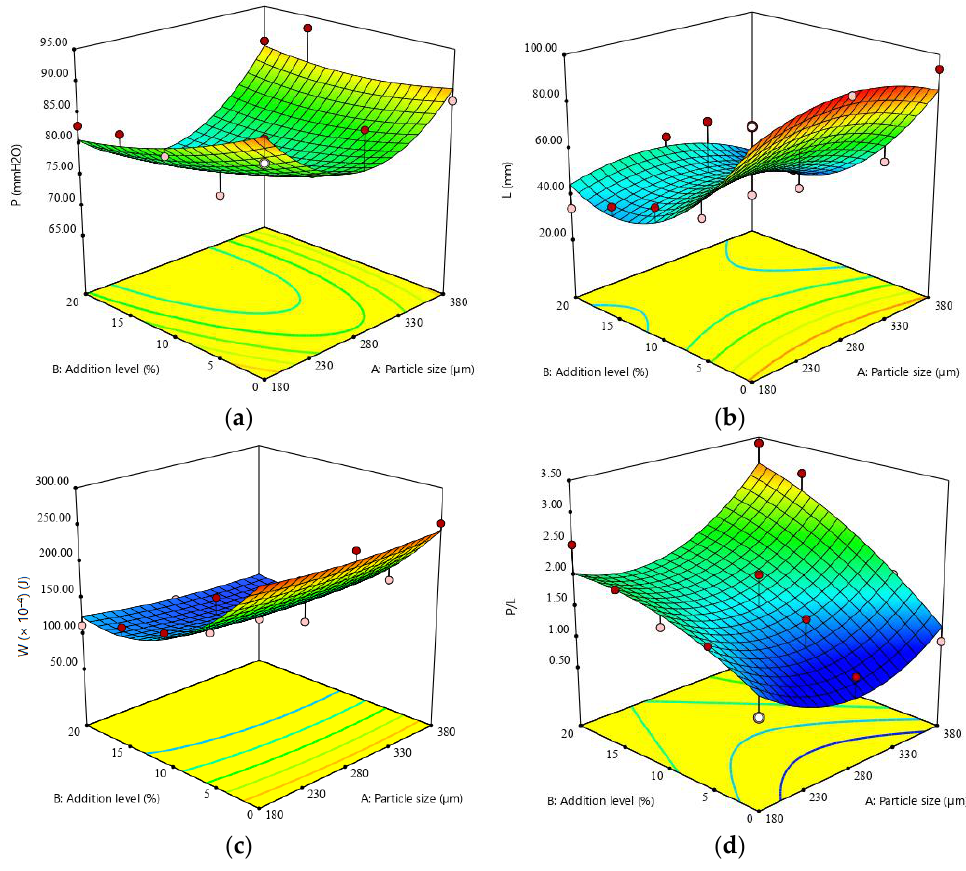
Figure 3. Response surface graphic of ( a ) dough tenacity (P), ( b ) dough extensibility (L), ( c ) defor- mation energy (W), and ( d ) alveograph ratio (P/L) as a function of buckwheat flour fractions and addition